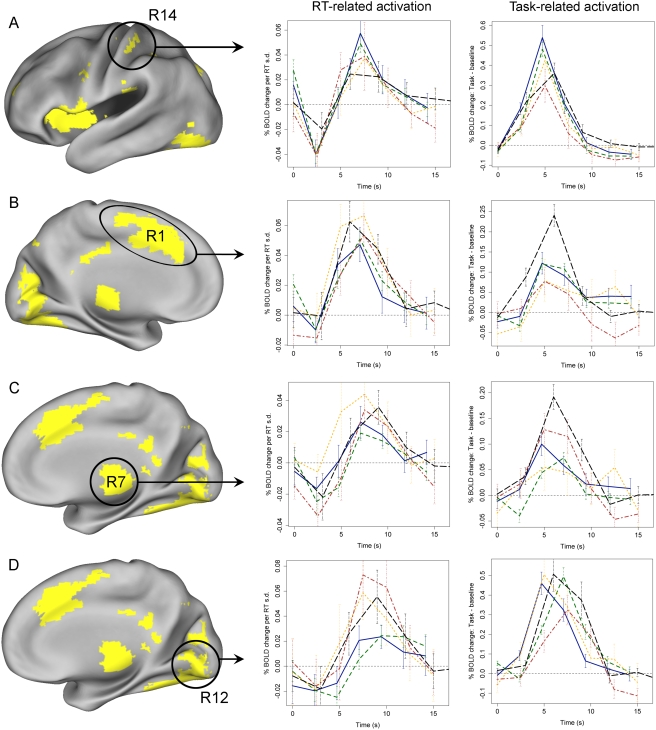
Time courses of RT-related activation in representative gray matter ROIs.Each line represents activation in a different sample. Left time course column: RT-related activation; right time course column: general task-related activation (i.e., task vs. baseline). Region labels (R14, R1, R7, R12) refer to region IDs in Table 2. Error bars reflect 95% confidence intervals.